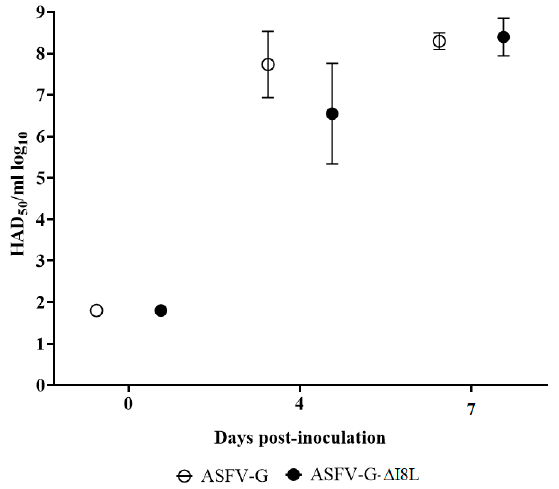
Figure 5. Viremia titers detected in pigs IM inoculated with 10 2 HAD 50 of either ASFV-G- ∆ I8L (filled symbols) or ASFV-G (empty symbols). Each time point represents the average and SD of values in each of the groups. Sensitivity of virus detection: >log 10 1.8 HAD 50 /mL.